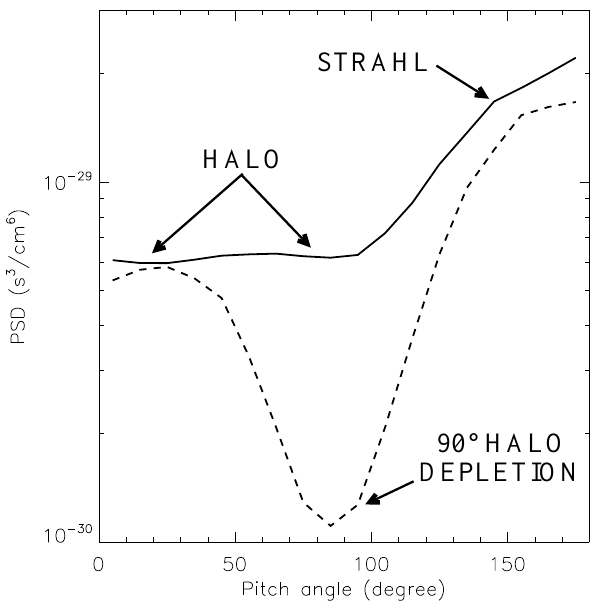
Fig. 4. Sample suprathermal electron PA spectra at ∼ 250eV. Those are not from the event of Fig. 3, and are merely used here to exem- plify the definitions used in Sect.